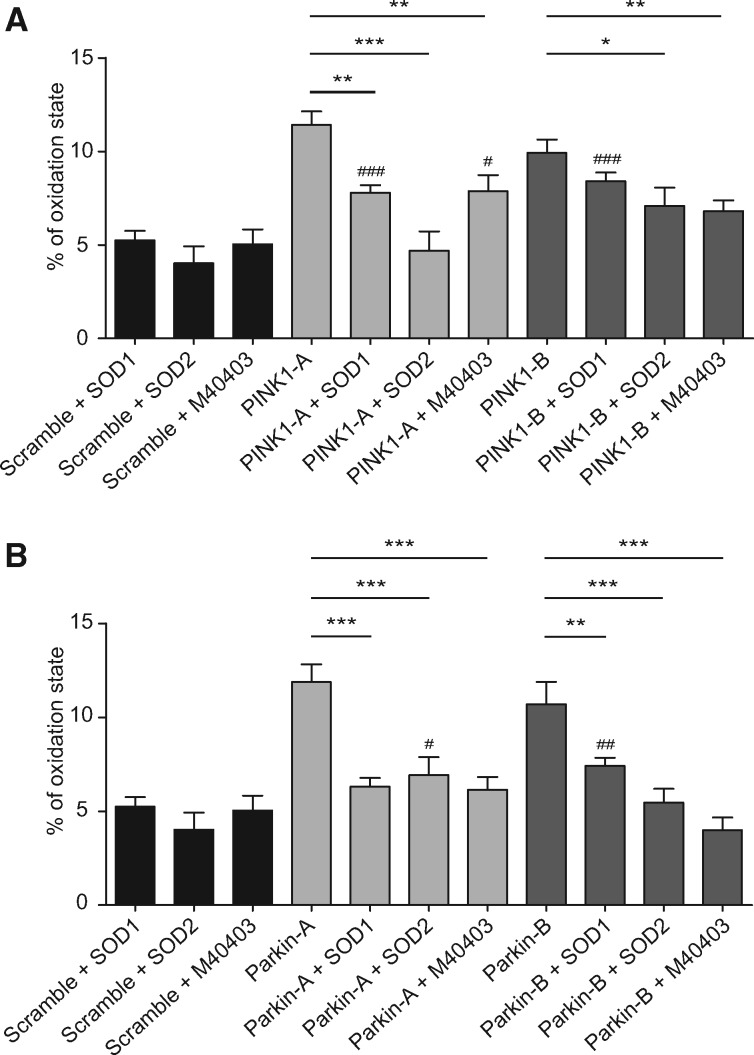
Effects of superoxide dismutation in the mitochondrial redox state of PINK1- and Parkin-edited SH-SY5Y cells—Wild-type, SOD1- or SOD2-overexpressing SH-SY5Y cells were transfected with scramble, CRISPR-PINK1- or CRISPR-Parkin vectors and treated with M40403 when indicated. Fluorescent ratios (405/488) were normalized with respect with the ratios corresponding to the 100% reduced and oxidized state. Data from three independent experiments are reported as mean ± SEM and statistical significance was determined by One-way ANOVA with Dunnett’s post-hoc analysis. #P < 0.05, ##P < 0.01 and ###P < 0.001 compared with scramble transfected cells and *P < 0.05, **P < 0.01 and ***P < 0.001 as indicated in the graph.